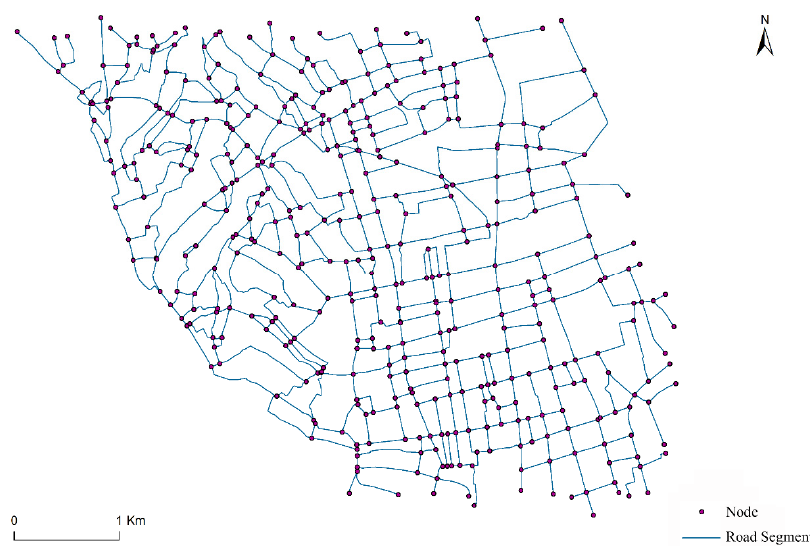
Figure 8. The original road network data.